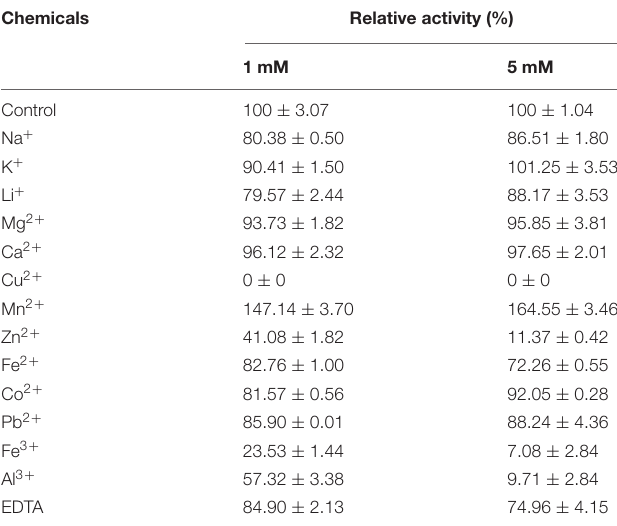
TABLE 2 | Effects of different chemicals on the enzyme activity of purified